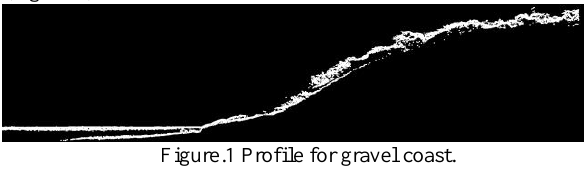
Figure 4: Flowchart of the proposed